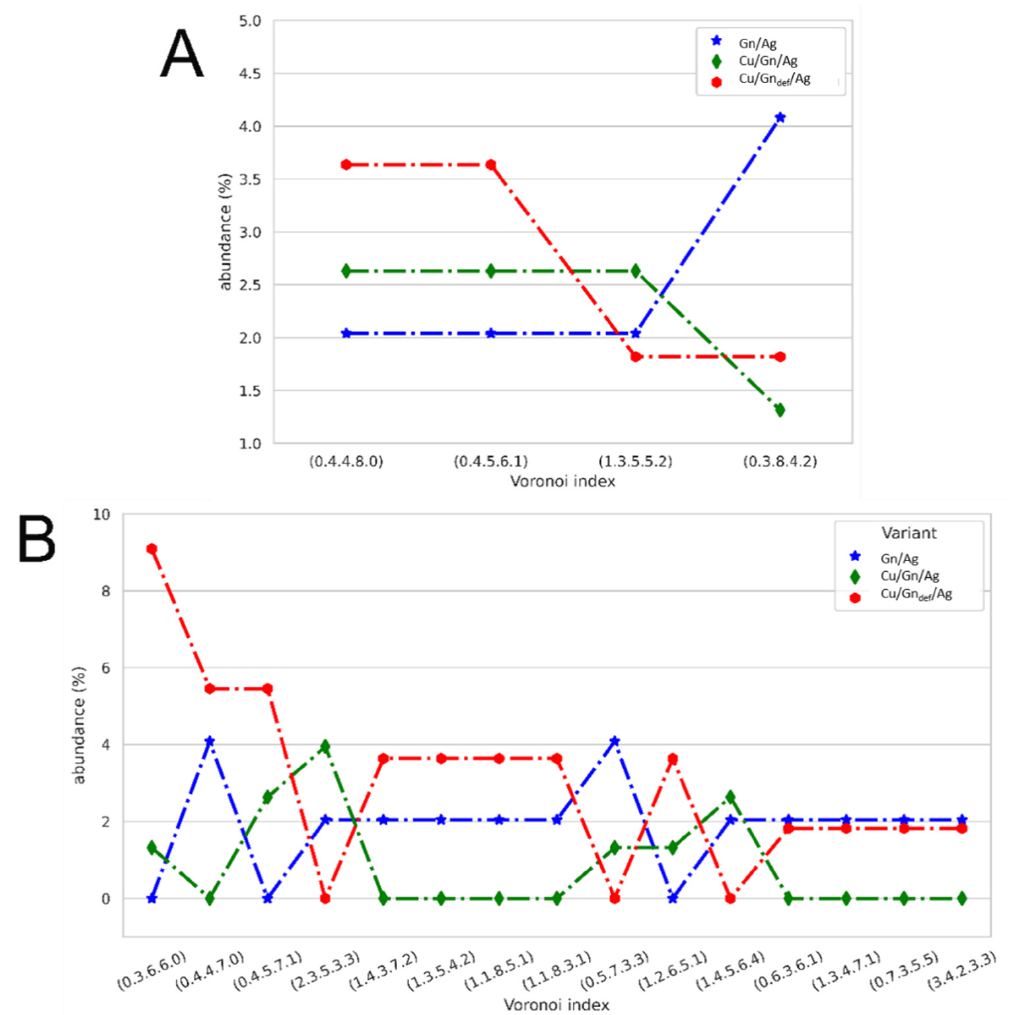
Figure 7. A graph abundance of VC types in considered substrate variants: Gn, Cu/Gn and Cu/Gn def . ( A ) VC types found in three substrate variants. ( B ) VC types occurred in two variant.